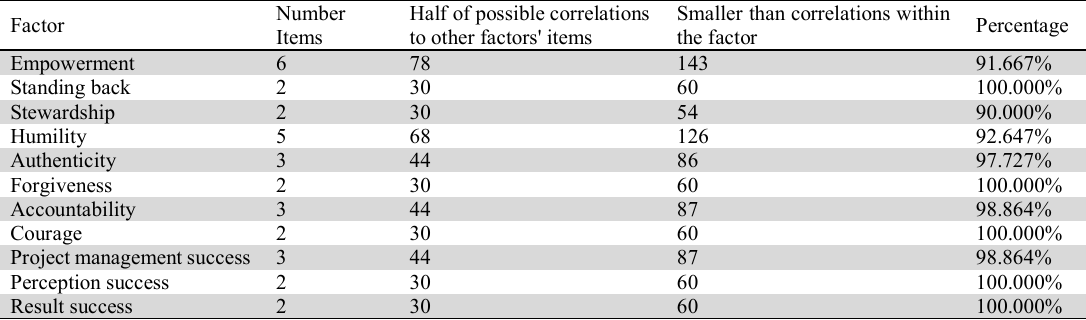
Examination of correlations of items of impact